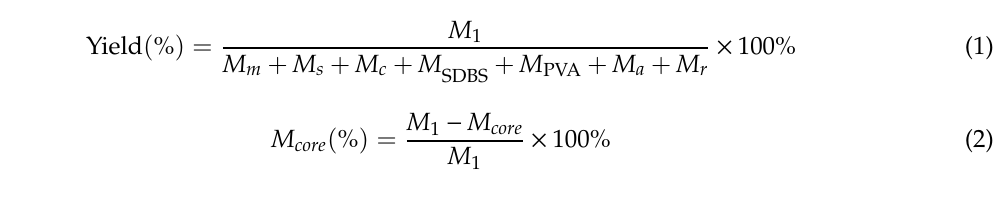
Table 1. Synthesis conditions and main index of the microcapsules.